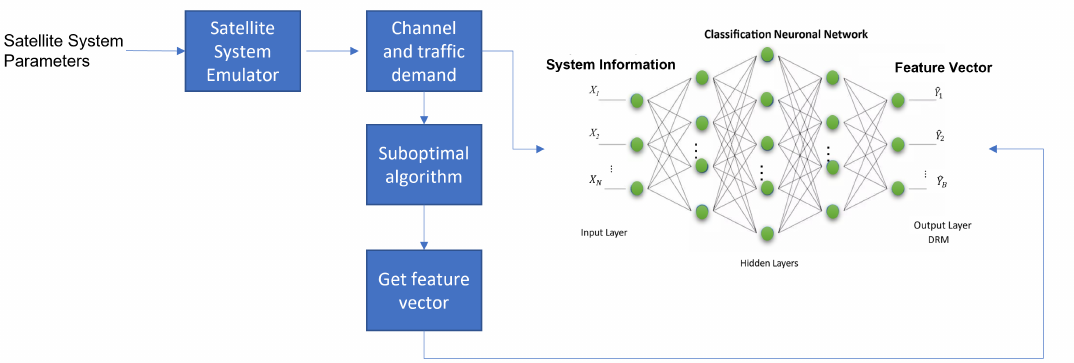
Figure 5. Data generation to DNN training for Beam Hopping (BH)